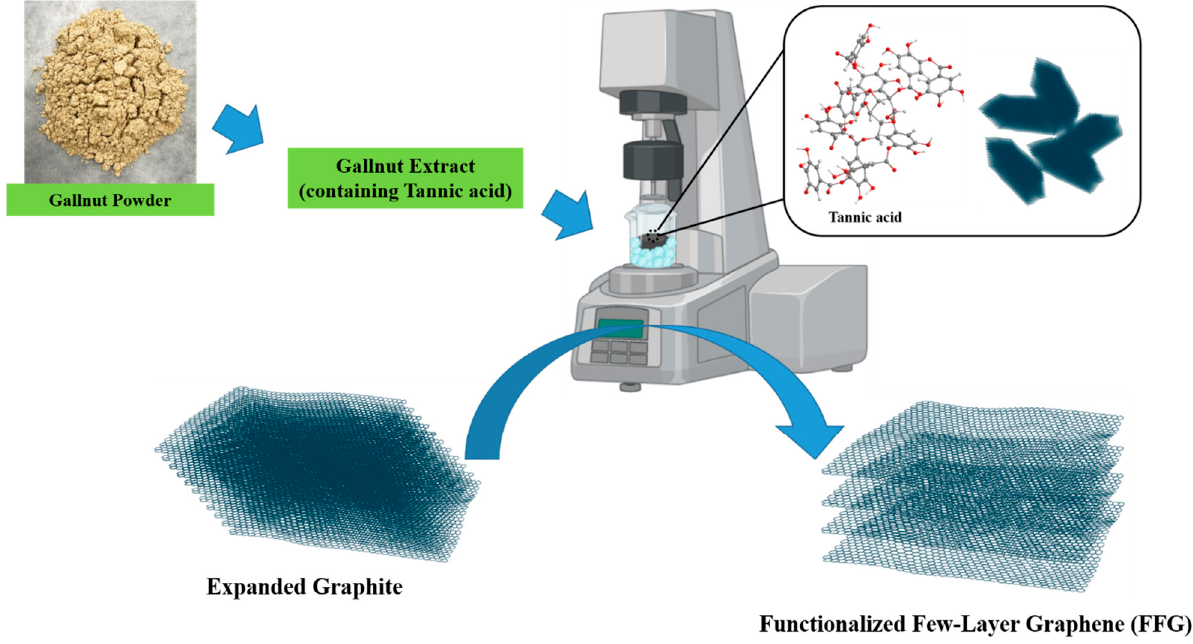
Figure 1. Schematic diagram for the preparation process of FFG.